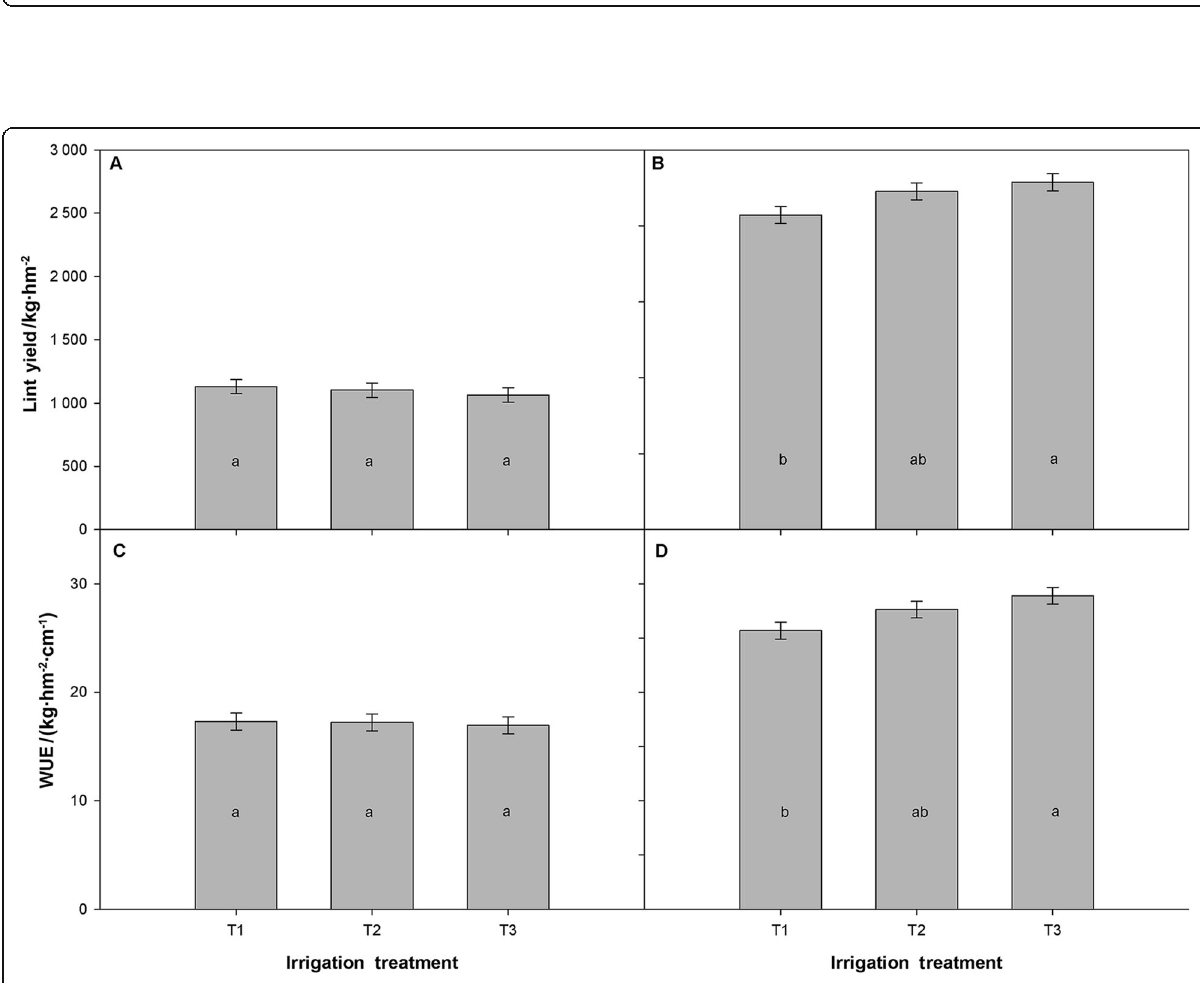
Fig. 5 Lint yield and water use efficiency (WUE) in the 2014 ( a , c ) and 2015 ( b , d ) growing seasons (kg·hm -2 ·cm -1 ) under irrigation regimes T1-T3 at a field site near Tifton, GA. Values are means ± standard error ( n =6), and bars not sharing a common letter within a given year are significantly different ( P